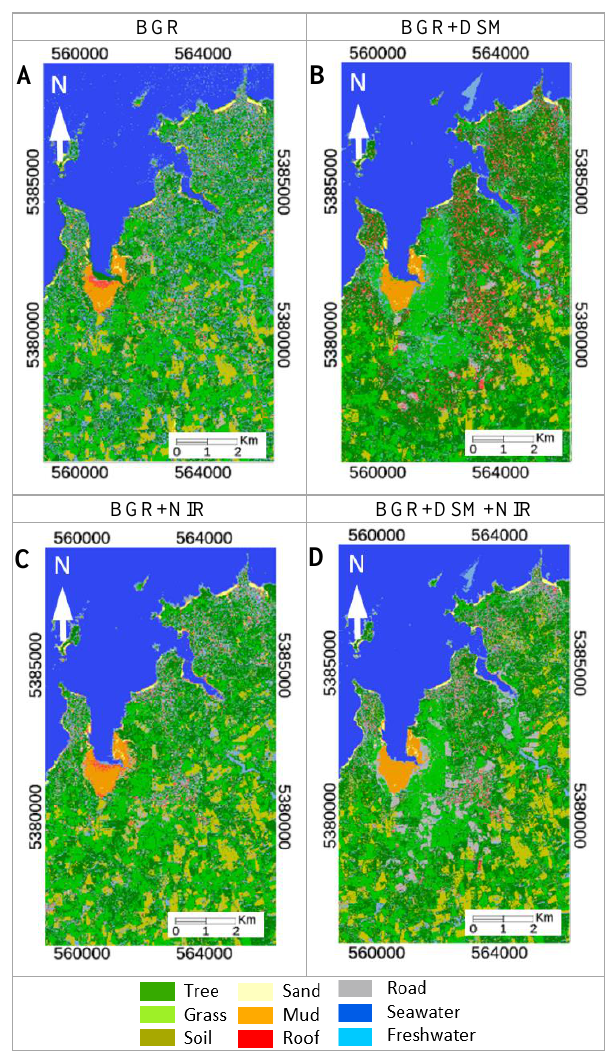
Figure 7. Maps of the land use/land cover classifications of the (A) Support Vector Machine. Reference blue-green-red (BGR); (B) BGR + near-infrared (NIR); (C) BGR + digital surface model (DSM); (D) BGR + NIR +